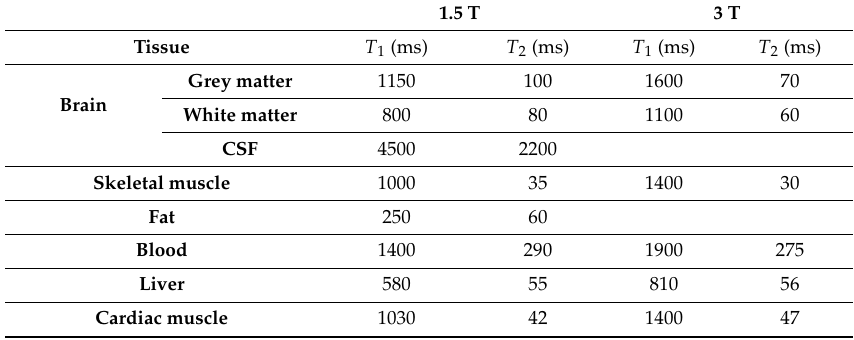
Table 1. Typical relaxation times values of some tissues at clinical magnetic